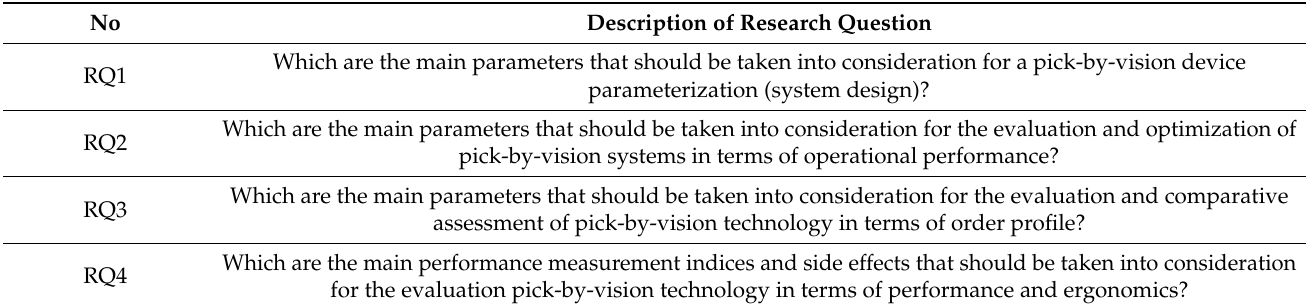
Table 1. Research questions for the identification, detection, and categorization of parameters that affect the design and operation of the proposed pick-by-vision system.